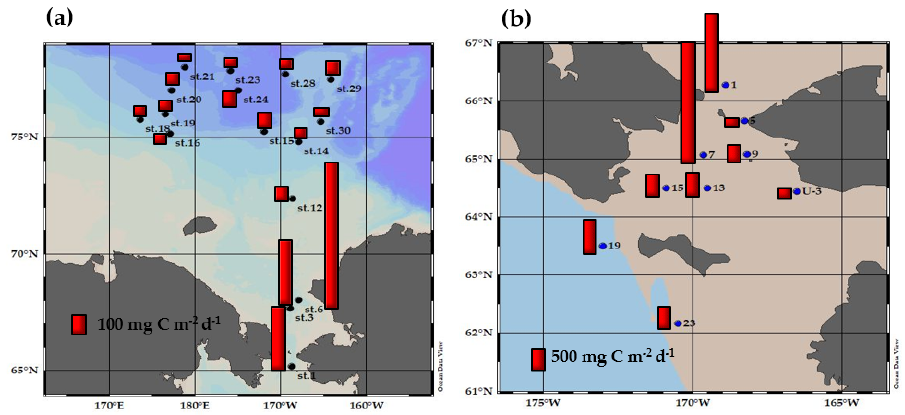
Figure 7. Primary production of total phytoplankton during the ( a ) ARA07B and ( b ) OS040.